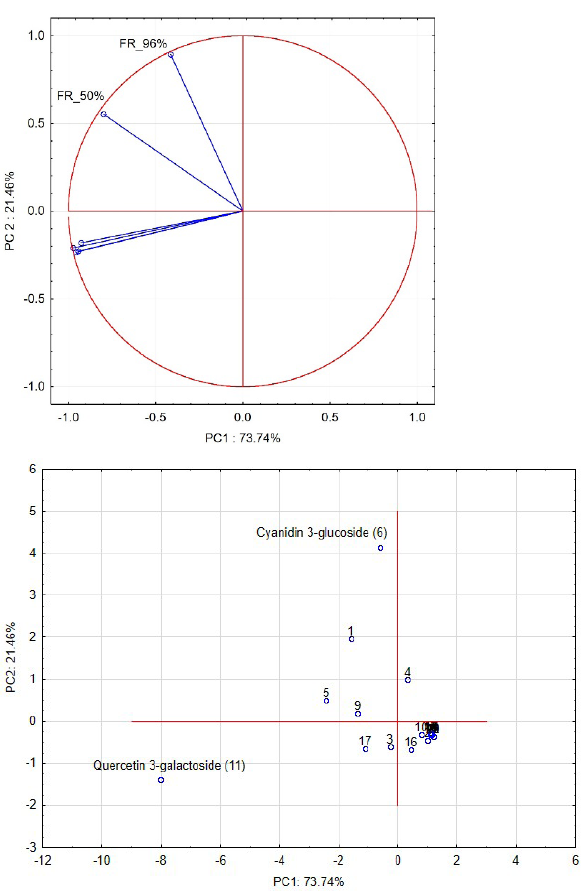
Figure 1: (A) Factor loads of PC1 vs PC2; (B) The determination of components that discriminate the differences between the extracts based on PCA